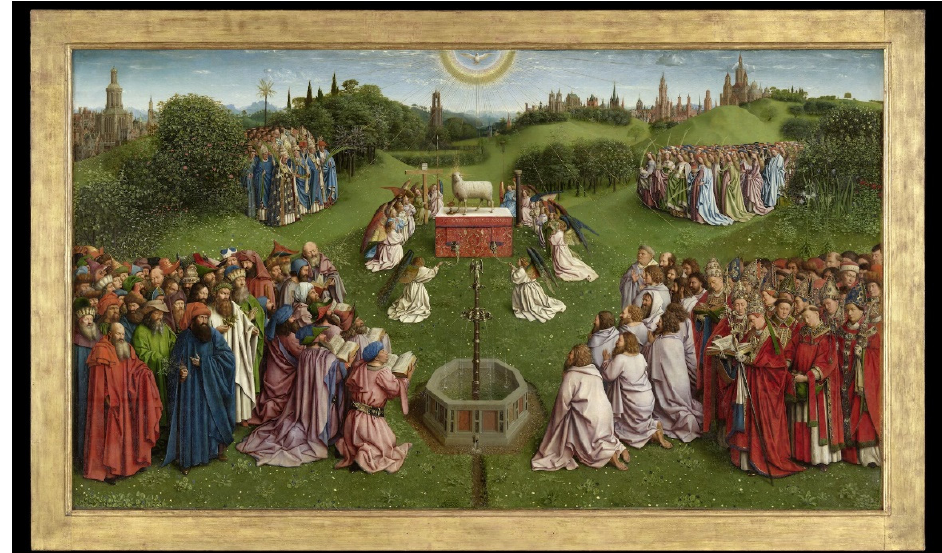
Figure 5. Detail of Figure 1.